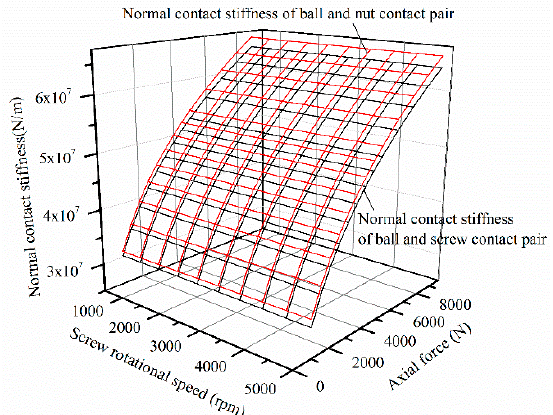
Figure 16. Variation of the first contact pair normal contact stiffness with the axial force and the screw speed.